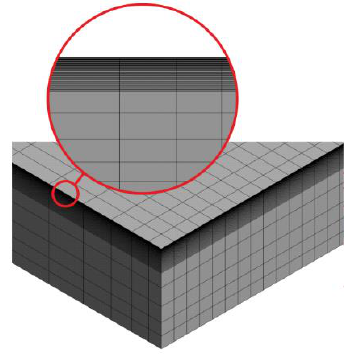
Fig. 8. Cross section of mesh No. 5.